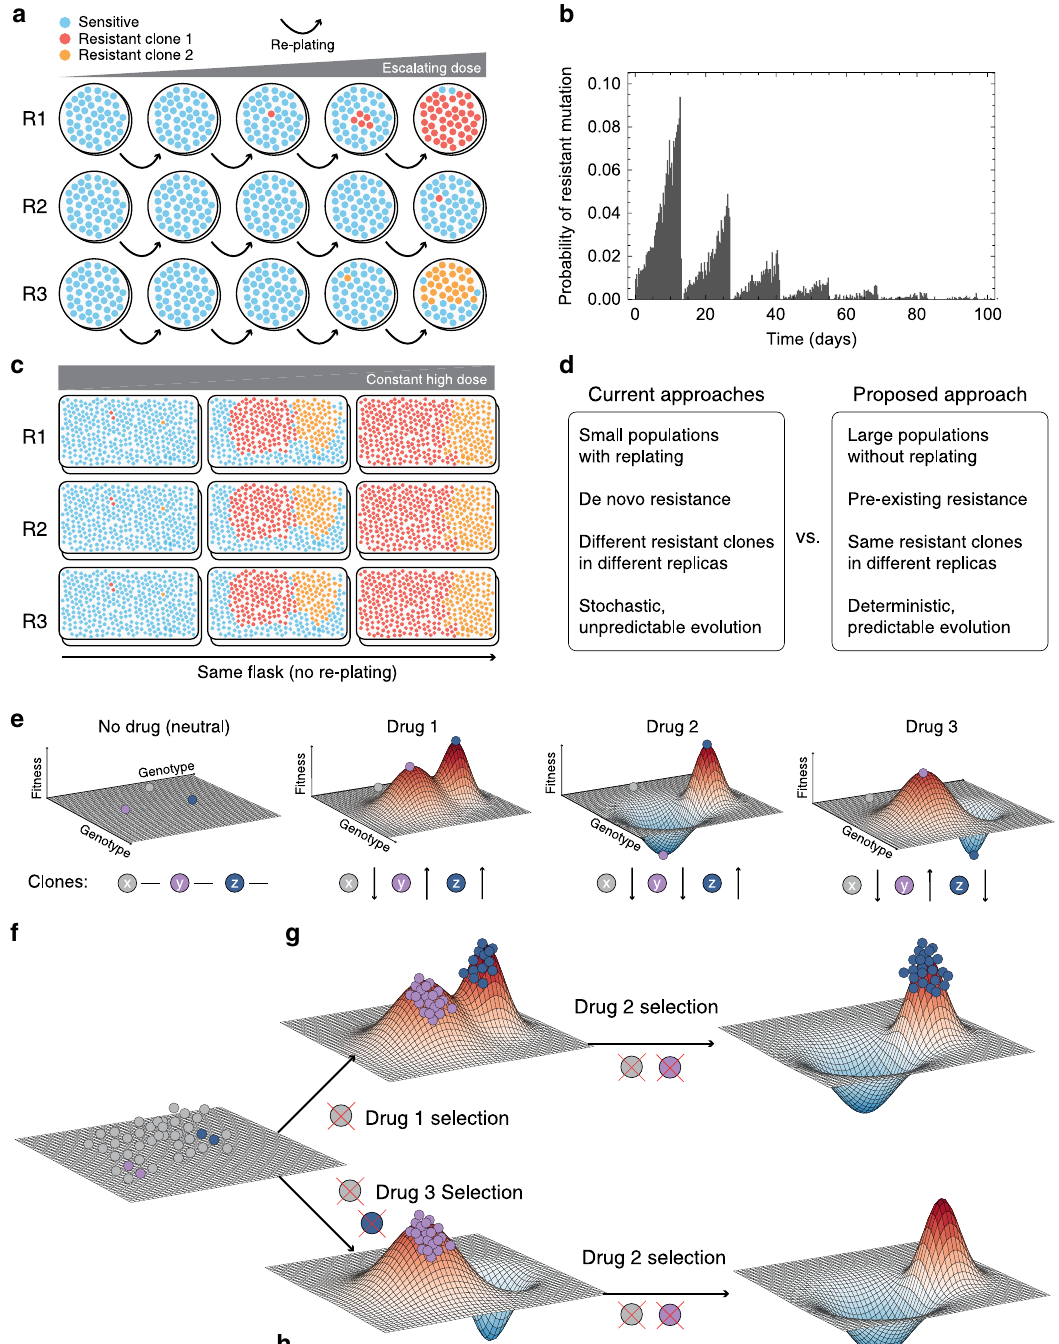
Fig. 1 Limits of current approaches to study the evolution of cancer drug resistance through fi tness landscapes. a Current approaches use small populations with re-plating and escalating drug dose to produce de novo resistant lines over a period of 6 – 12 m. Evolutionary dynamics in this setting are highly stochastic, with different mutants arising at distinct times in different replicates. b Stochastic modelling of waiting time to the emergence of a resistant clone in current experimental approaches shows that this is extremely variable (re-plating every 2 weeks, 1:10, resistant mutation rate 2 × 10 − 8 , 10 4 simulations). c Systems accommodating large populations are more likely to contain pre-existing resistant subclones, can be grown without re-plating, and lead to evolutionary dynamics of resistance that can be largely deterministic, reproducible and predictable. d Summary of the differences between current approaches and the approach we propose. e The selective effect of a drug on a heterogeneous population can be visualised as a fi tness landscape. Genetically distinct cells are represented by points in the horizontal plane, whilst their fi tness within a certain environment is the vertical axis. Different drugs have different landscapes, selecting against different clones. For simplicity, here we assume in the absence of drug all clones to be equally fi t ( fl at landscape). Drug 1 changes the landscape, selecting for y and z but against x . Drug 2 selects only for z and drug 3 only for y . f First, a population of cells is present at baseline, represented here as equally fi t for simplicity. g Drug 1 selects clones that are resistant to drug 2. h Applying fi rst drug 3 leads to evolutionary steering of a population that is entirely sensitive to drug 2. Here genotypes with values below the plain have negative fi tness and so their frequency will decrease until they go